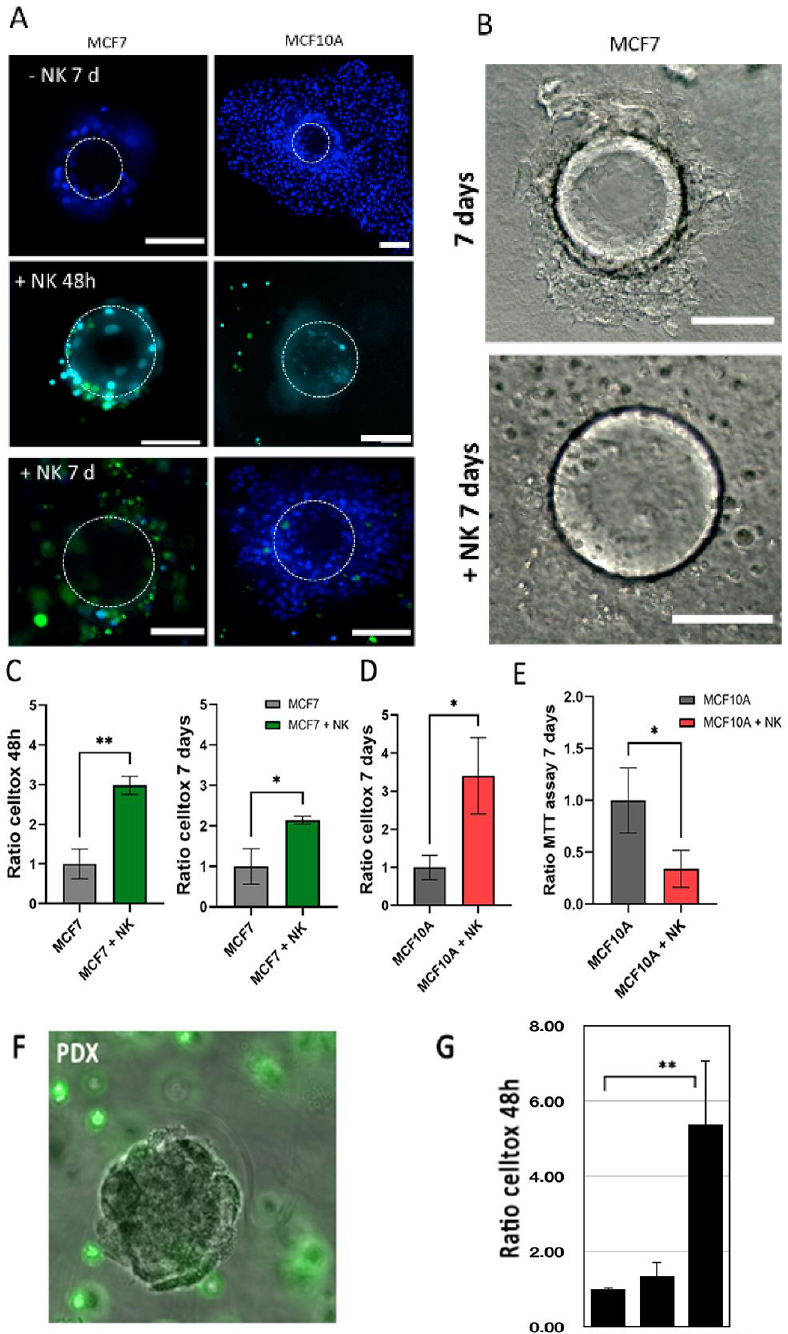
Figure 6. Immune cells NK-92 can detect and kill tumor cells in our models. ( A – C ) MCF7 and MCF10A cells were cultured on a microsupport in a collagen I/BME mix for 48 h and 7 days with and without NK-92 cells, stained with green CFSE. Dotted circle indicate microsupport location. All nuclei were stained with Hoechst dye ( B ) MCF7 cultured on a microsupport after 7 days with and without NK-92 in bright field. ( C ) Cytotoxicity was evaluated using Celltox on MCF7 after 48 h and 7 days. ( D ) Cytotoxicity was evaluated using Celltox on MCF10A after 7 days. In addition, MTT assay was performed on MCF10A after 7 days. Scale bar: 100 µm. ( E ) MCF1O1 were also tested for proliferation using MTT assay, with or without NK cells. ( F ) PDX explants were immersed in a collagen I/BME mix with stained NK-92 cells. ( G ) Cytotoxicity was evaluated by Celltox after 48 h for PDX cells and NK92 cells, isolated or combined. * for p < 0.05 in a Student T test comparing columns as indicated. ** for p < 0.001